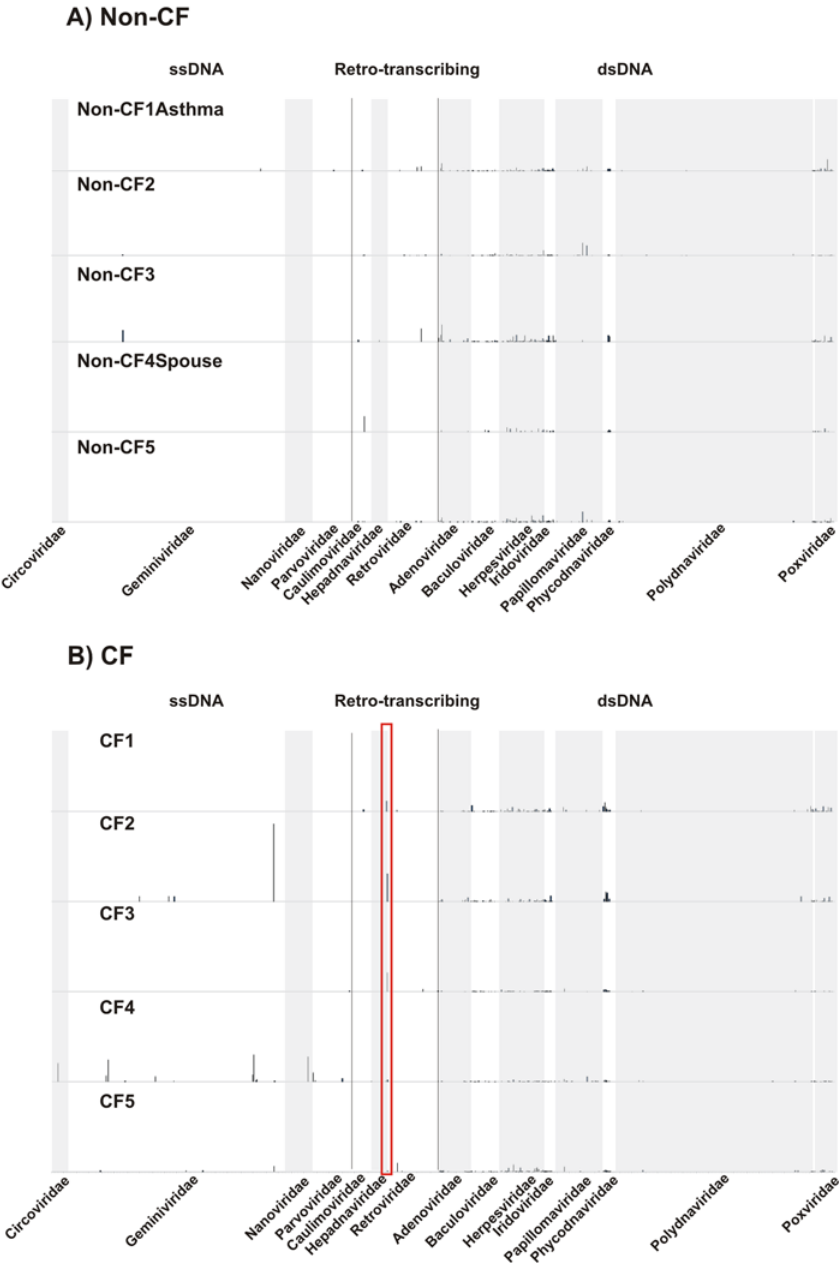
Figure 4. Distribution of normalized best tBLASTx hits to DNA and Retro-transcribing eukaryotic viruses in Non-CF(A) and CF(B) individuals. Reticuloendotheliosis virus is indicated by the red rectangle in (B).